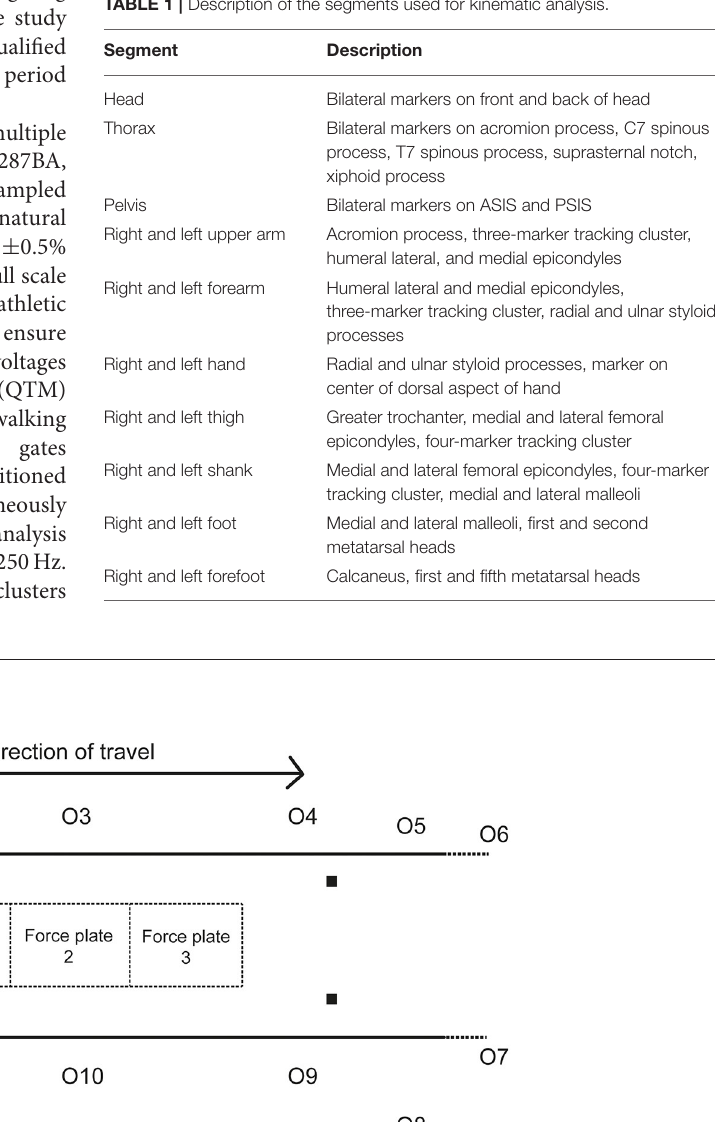
TABLE 1 | Description of the segments used for kinematic analysis.